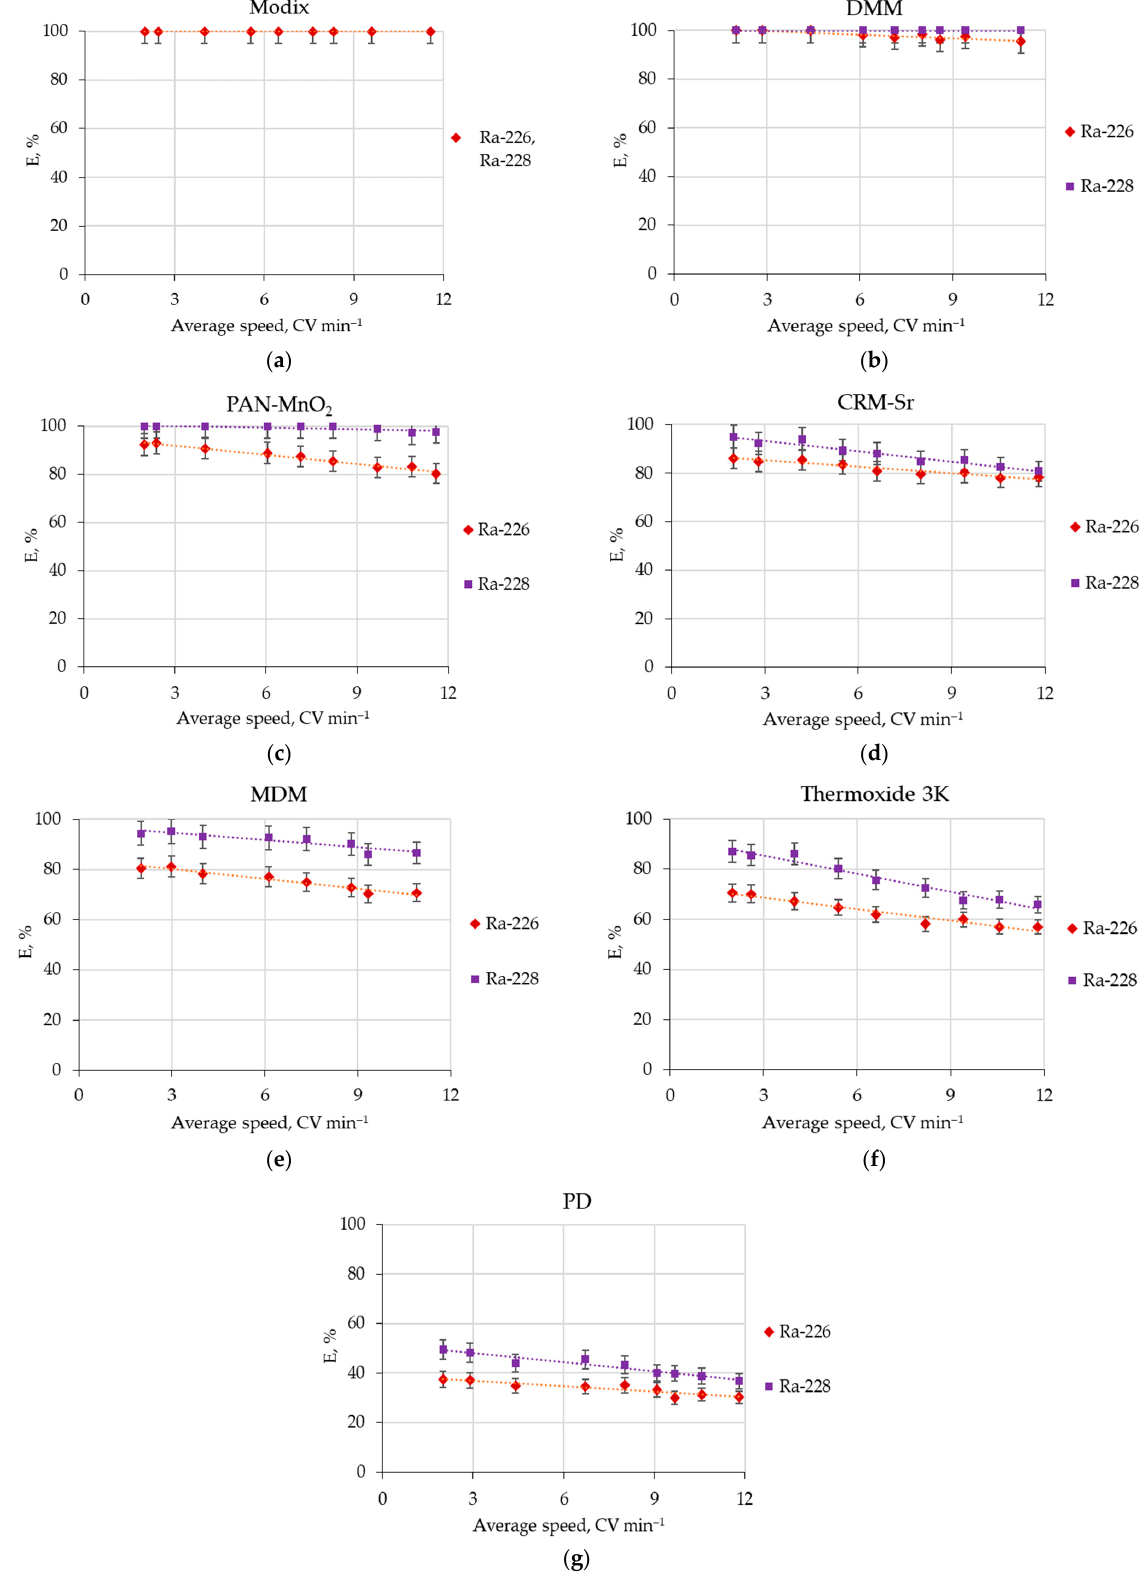
Figure 2. Dependence of 226 Ra and 228 Ra recovery efficiency ( E , %) on the seawater flow rate by sorbents: ( a ) Modix; ( b ) DMM; ( c ) PAN-MnO 2 ; ( d ) CRM-Sr; ( e ) MDM; ( f ) Termoxid 3K; ( g ) PD (two-column method, two columns with sorbents volume 25 mL each, seawater volume—250